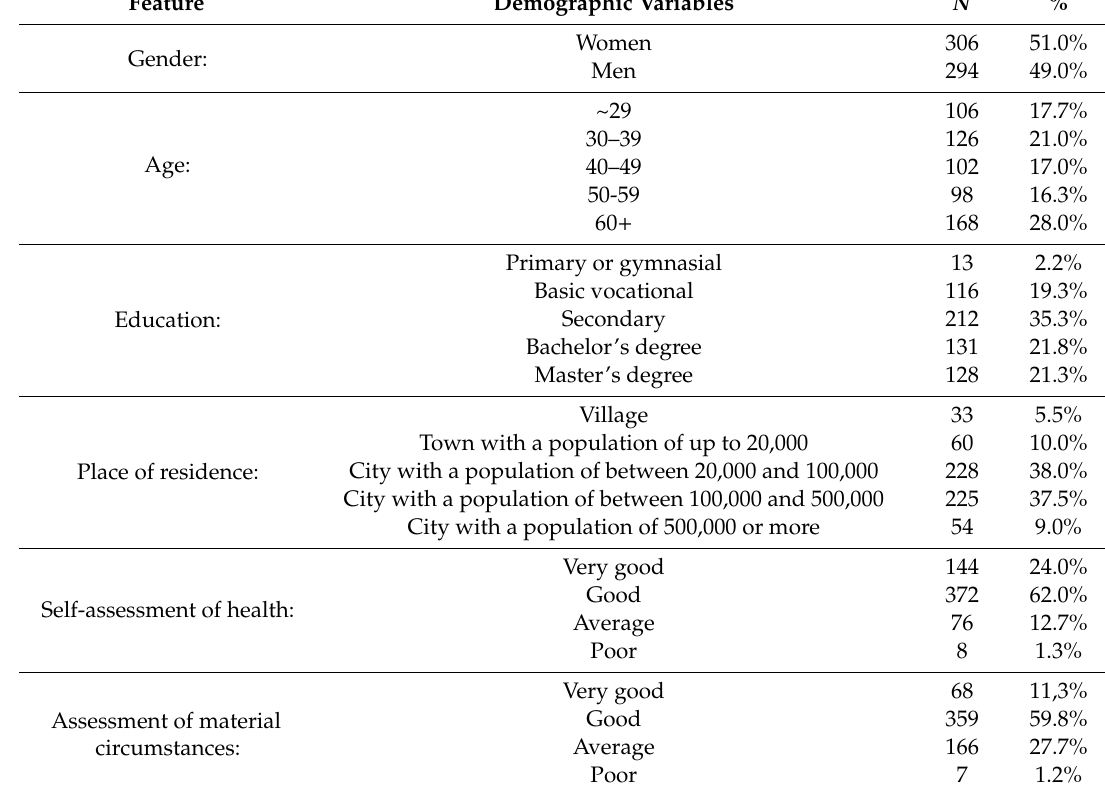
Table 1. Characteristics of the research